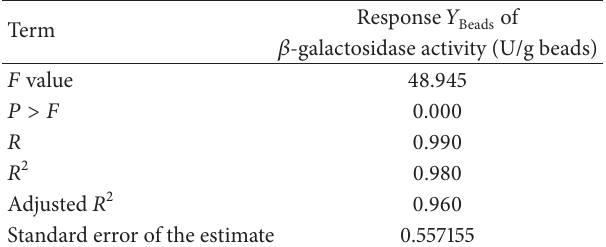
0.557155 Table 4: Kinetic constants of free and immobilized 𝛽 -galactosidase. 𝛽 -Galactosidase form Kinetic